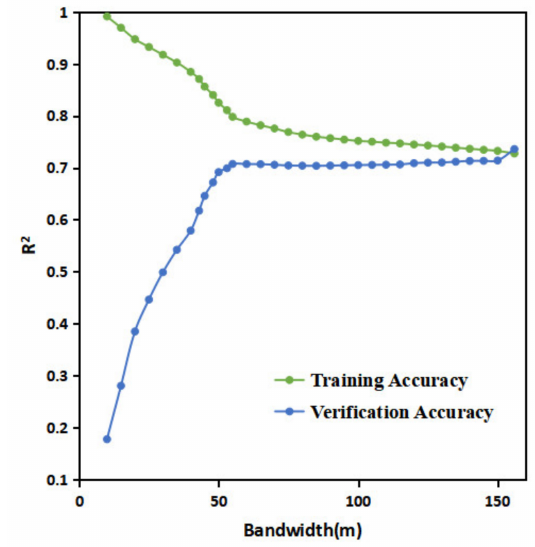
Figure 11. Influence of bandwidth selection on